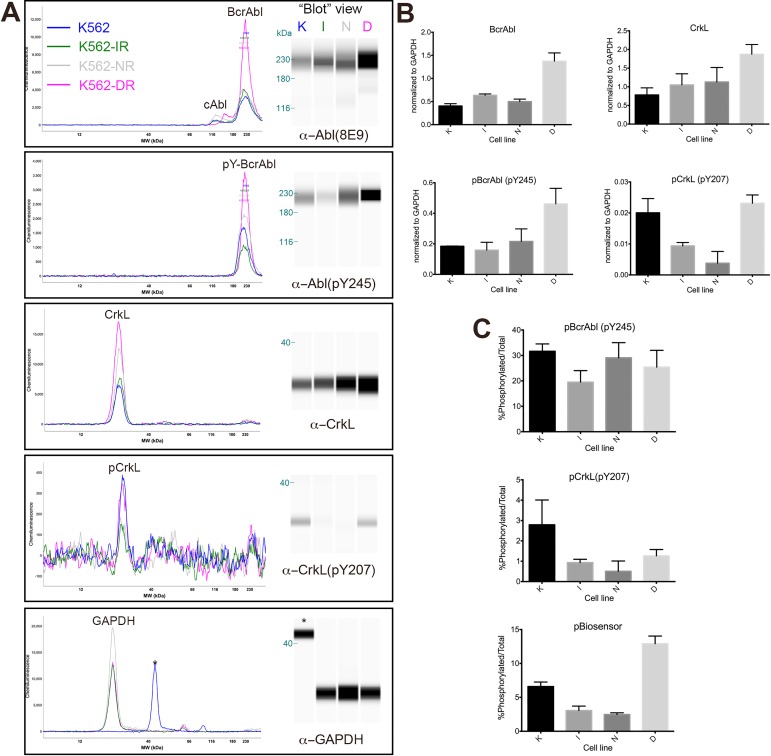
Immunodetection of Abl/BcrAbl, CrkL, and relevant site-specific phosphorylation.Lysates from parental (K), K562-IR (I), K562-NR (N) and K562-DR (D) cells cultured in the absence (K) or presence (I, N and D) of maintenance concentrations of their respective TKIs were analysed in duplicate using the Wes capillary immunodetection system from ProteinSimple. (A) Individual capillary plots and pseudo-“blot” views (in which signal peaks are represented in “band” form) from chemiluminescence for one replicate from each antibody analysis: total Abl/BcrAbl (αAbl #2862, Cell Signaling Technology), phospho-Abl/BcrAbl (αpY245 ab195839, Abcam), total CrkL (αCrkL 32H4/#3182, Cell Signaling Technology), phospho-CrkL (αpY207 EP270Y/ab52908), and GAPDH (αGAPDH D16H11, Cell Signaling Technology). Peaks are labelled for the respective proteins; note that for GAPDH, one capillary lane (labelled with *) in this replicate exhibited artifactually shifted migration, however immunodetection was consistent with other capillaries. (B) Peaks from total BcrAbl, pYBcrAbl, total CrkL and pYCrkL were normalized to peaks from GAPDH for each duplicate, and plotted to show comparisons between the parental (K) and drug-resistant (I, N, D) cells. Error bars indicate SEM for duplicate runs. (C) GAPDH-normalized signals were used to calculate and compare %phosphorylated/total signal for BcrAbl (top) and CrkL (middle). Estimated % phosphorylated biosensor calibrated from the standard curve and compared with total binding capacity of the well, as described in Fig 6 legend) was re-plotted from data shown in Figs 4 and 6, and shown here (bottom) for comparison to endogenous protein %phospho/total. Note that “blot” images are digital representations of peak intensity, not photographic or scanned images of actual blots, and thus band shapes appear unnatural.